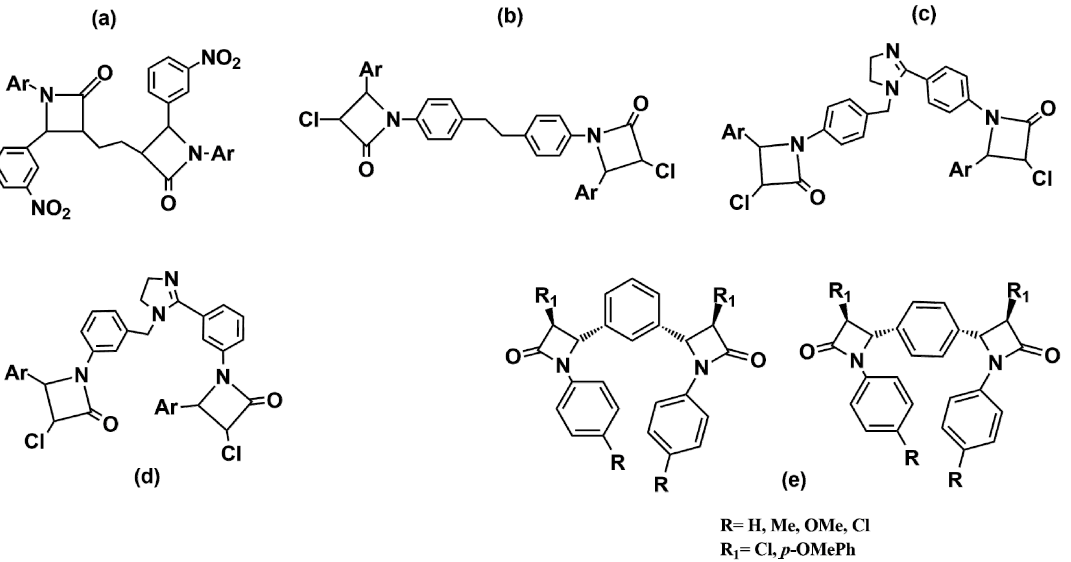
Figure 5. Chemical structures of bis-azetidinone connected by spacers of different types. Compounds ( a – d ) are reported in Refs. [20–22], compounds ( e ) in Ref. [23].